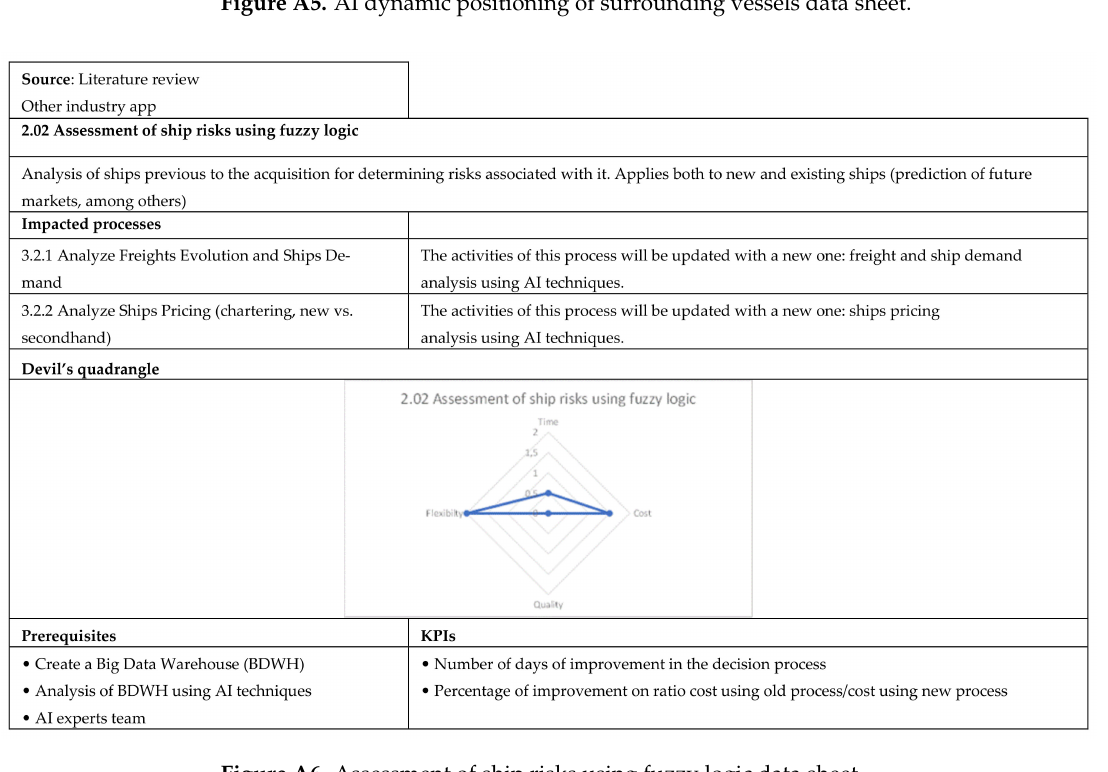
Figure A6. Assessment of ship risks using fuzzy logic data sheet.